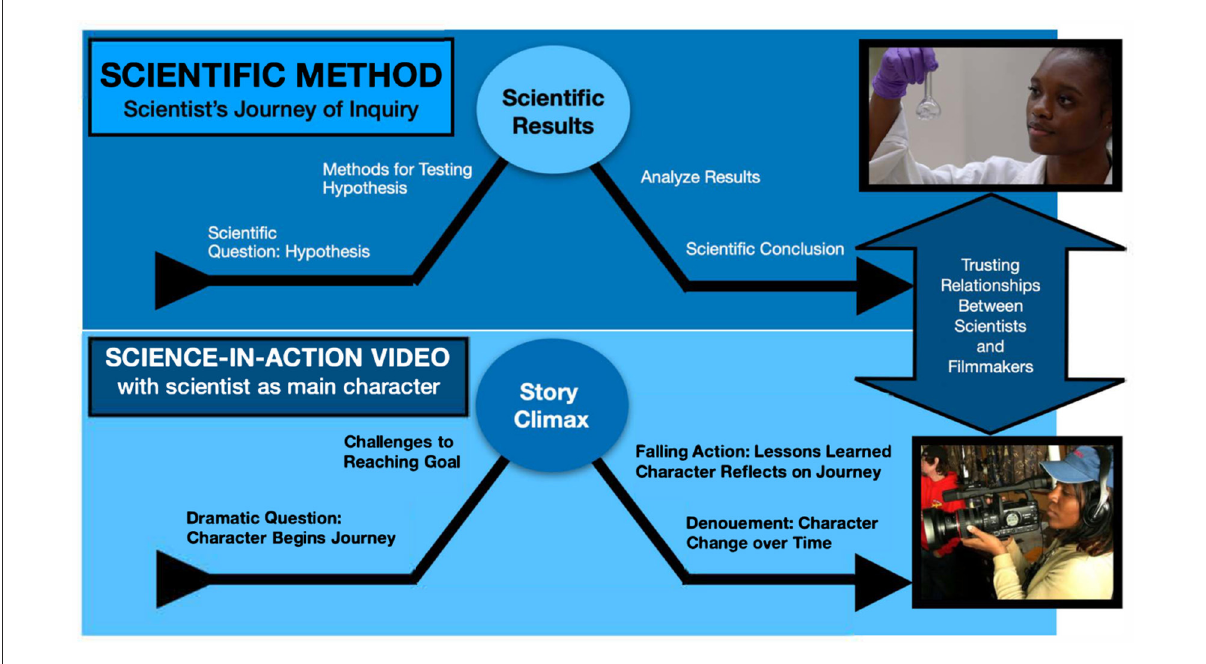
FIGURE1 Framework for science-in-action video storytelling.